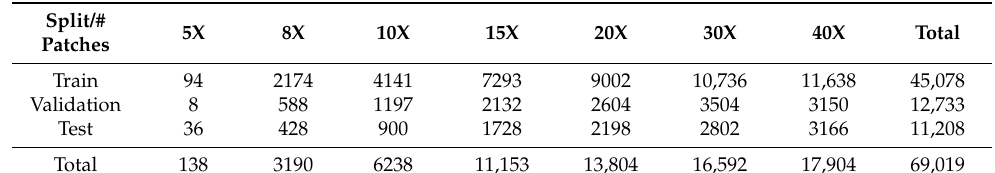
Table 1. Number of Estrogen Receptor-positive Breast Cancer (ERBCa+) patches extracted per magnification and partition.